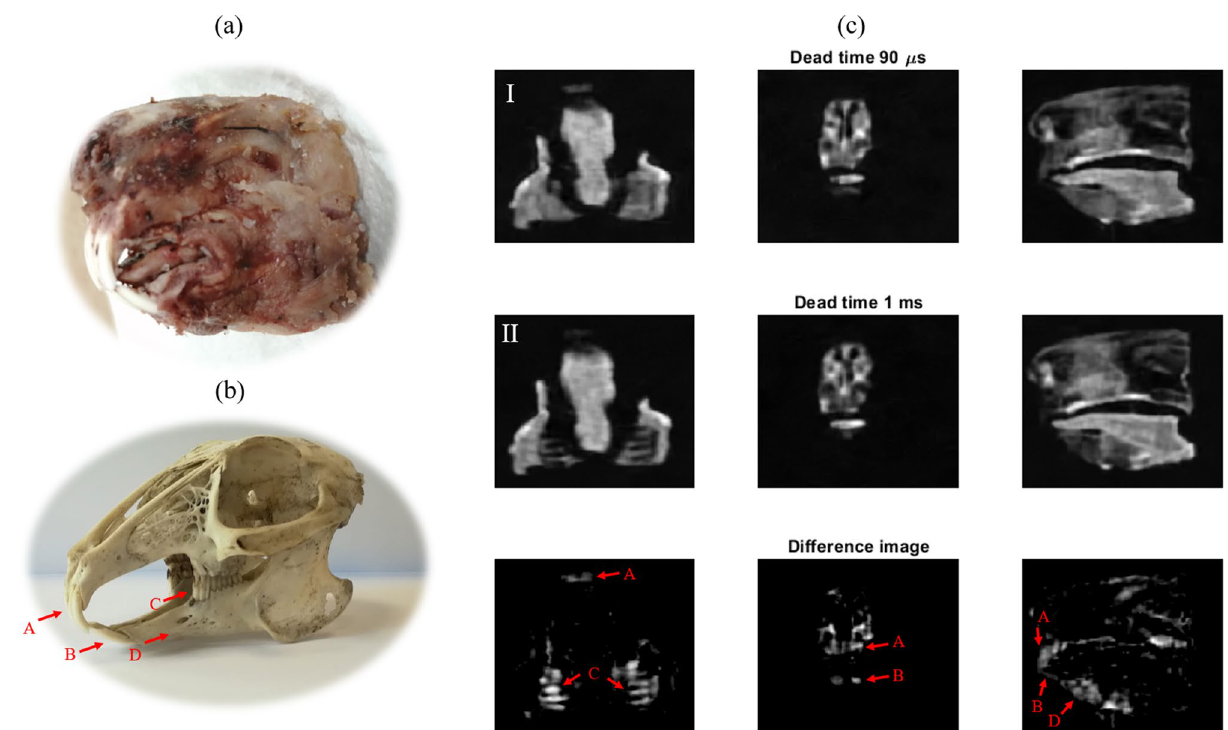
Figure 2. ( a ) Picture of the scanned rabbit head. ( b ) Picture of a rabbit skull. ( c ) Top: Single slices for 90 µ